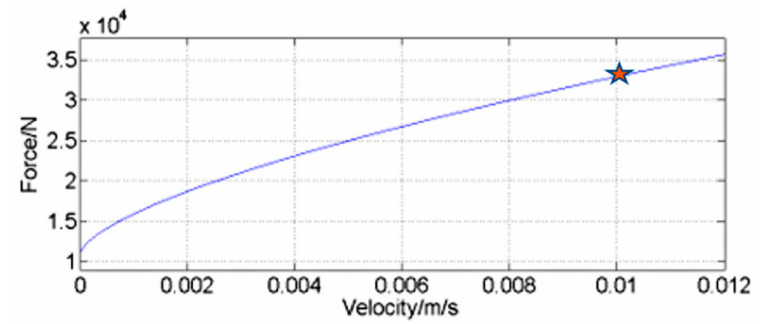
Figure 7. Damping rod’s force–velocity curve.